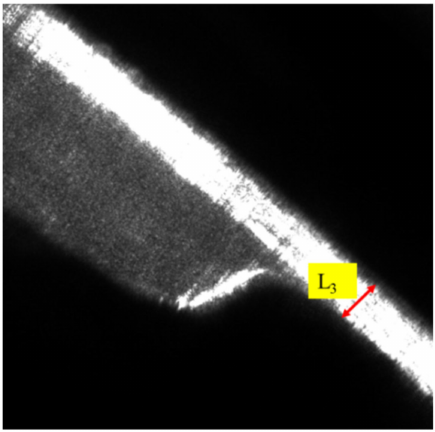
Figure 6. The first frame of the 7th and 8th pair of images.